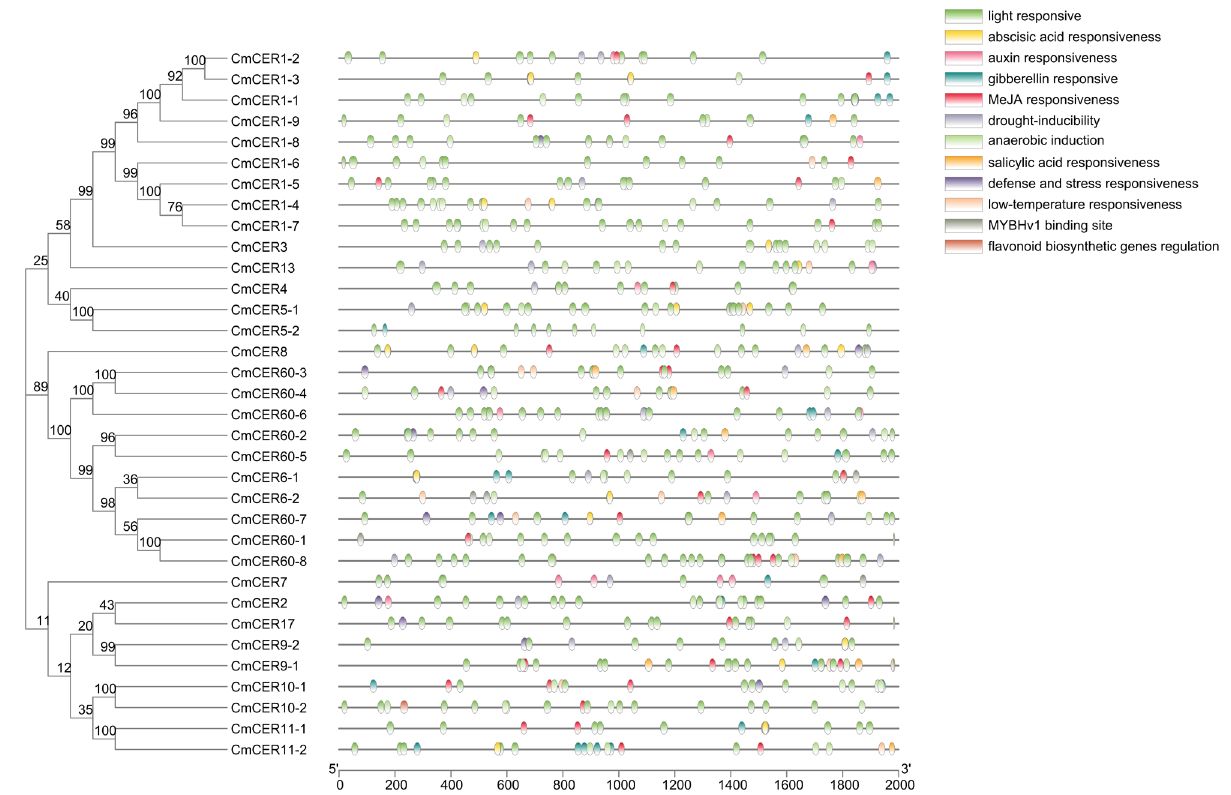
Figure 6. Cis-regulatory element analysis on CmCER genes.